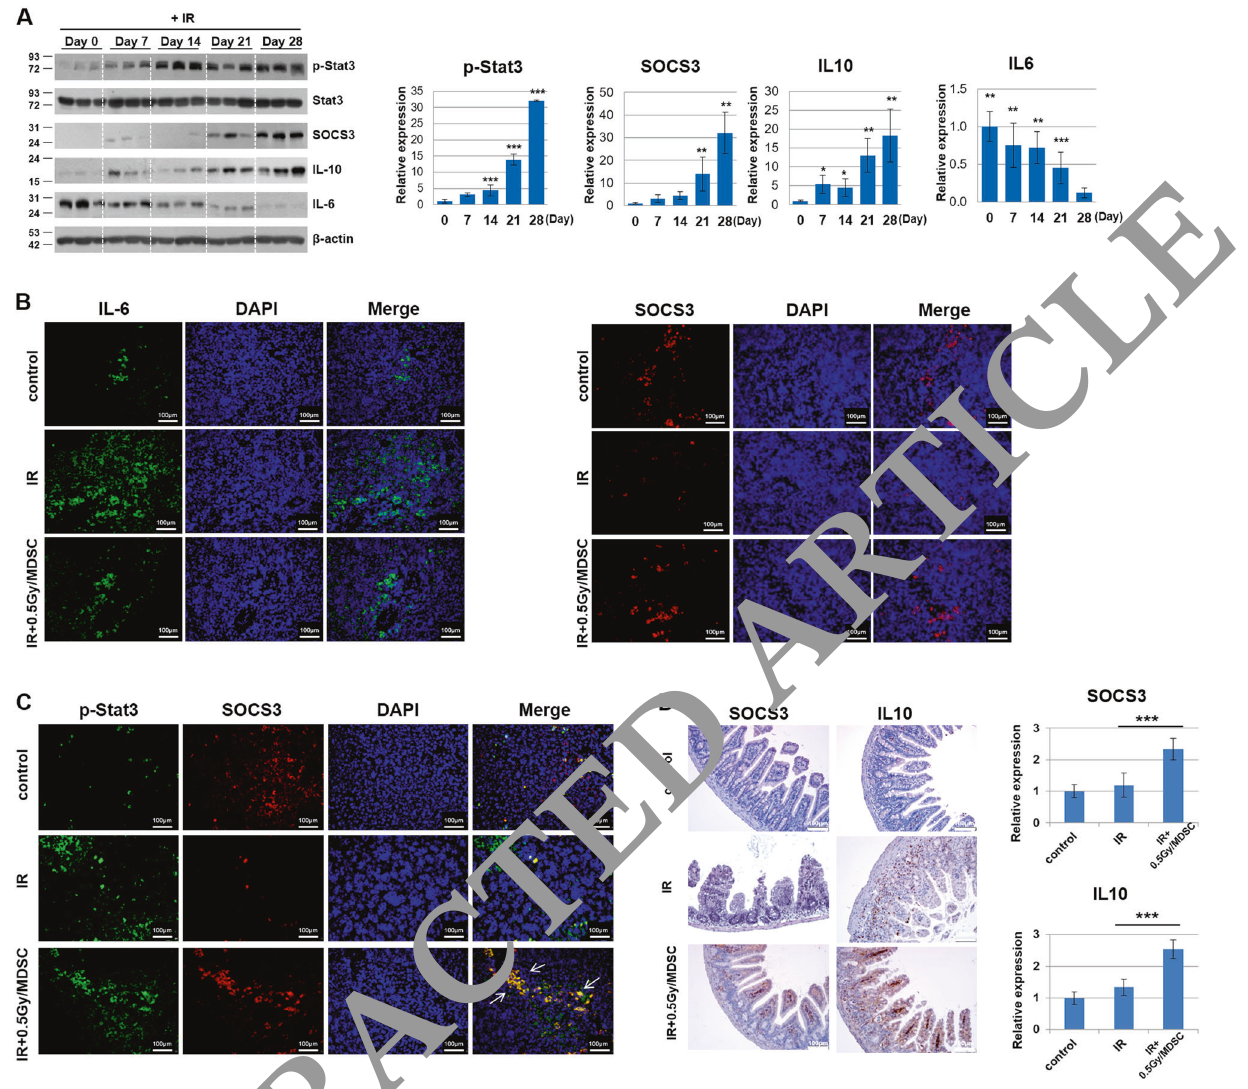
mice (0.5 Gy/MDSCs) were con fi rmed by western-blot analysis. β -actin was used as a loading control. The data are represented as the mean ±SD. * P <0.05, ** P < 0.01, *** P <0.001 vs. day 0. B Representative immuno fl uorescence images of spleen stained for IL6 (green), SOCS3 (red). Scale bar = 100 μ m. C Spleen was stained for p-STAT3 (green), SOCS3 (red) and p-STAT3 and SOCS3 (yellow) cells. DAPI staining (blue) was used to determine the number of nuclei. Scale bar = 100 μ m. D The levels of SOCS3 and IL10 in the intestine were evaluated using immunohistochemistry.